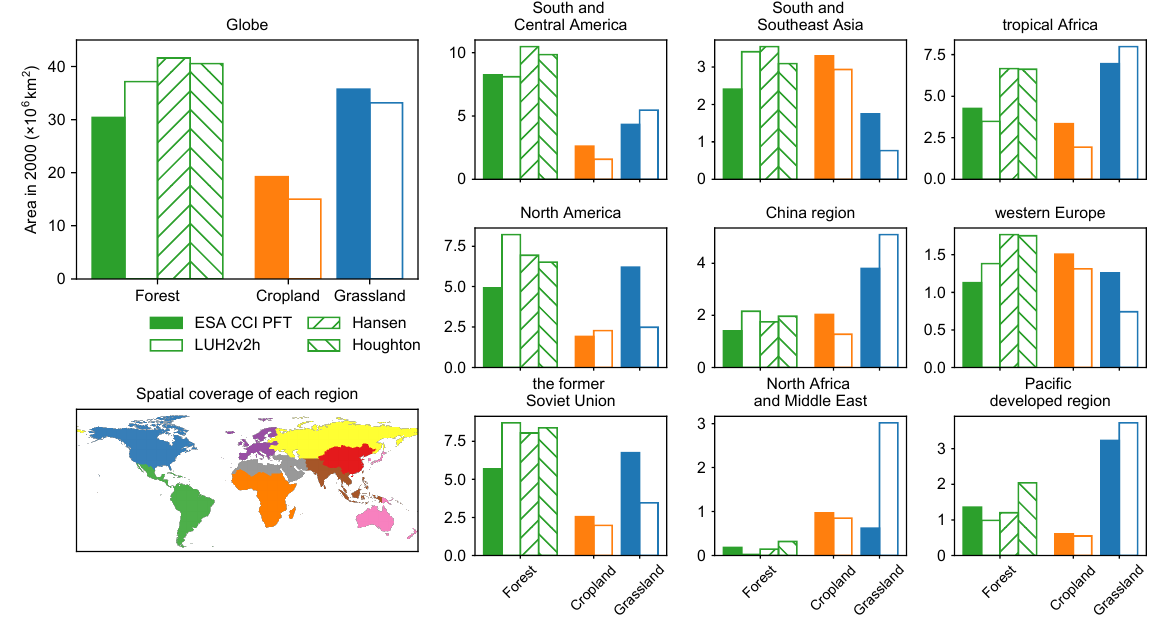
Figure 1. Global and regional areas of forest, cropland and grassland PFTs in the year 2000 in comparison with data from LUH2v2h (Hurtt et al., 2011), Hansen et al. (2013) and Houghton and Nassikas (2017). Different colours indicate different PFTs.